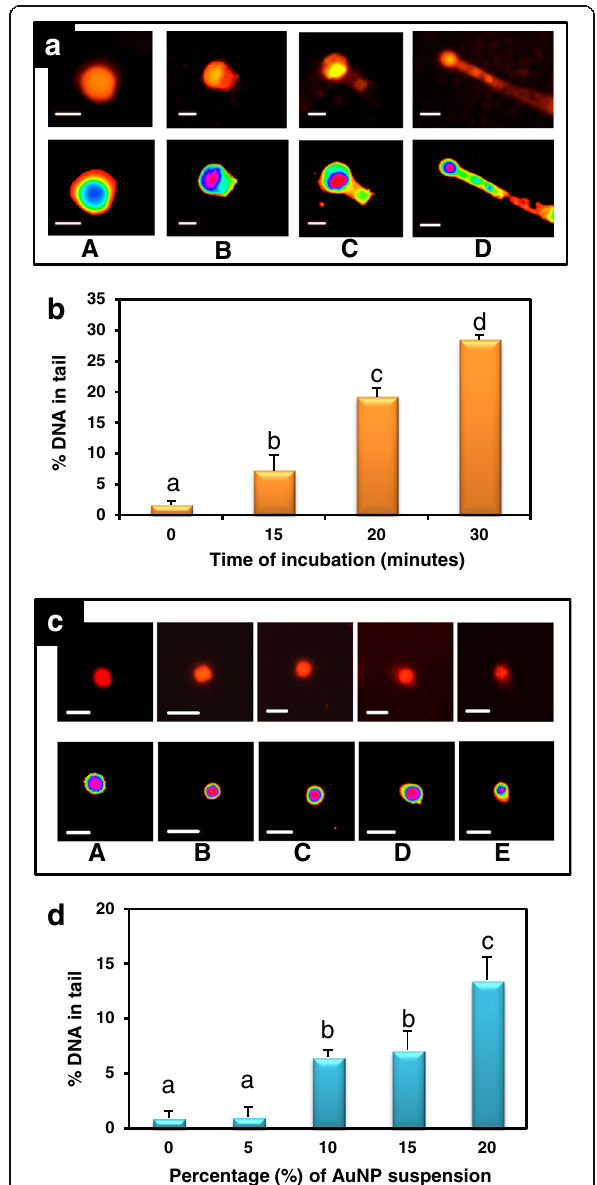
Fig. 8 Assay of apoptotic properties of the AuNPs. a Comet assay and fluorescent microscopic images of nuclei of tobacco leaves treated with AuNPs for A 0 min. B 15 min, C 20 min, and D 30 min (bar=5 μ m). In the control sets (0 min incubation), most of the DNA is located in the head of the comet while cells subjected to longer treatment show increasing DNA damage and longer comet tails. b Mean of % tail DNA ±SE after different periods of incubation. Data represents means±SE of three replicates. Different letters indicate statistically significant differences among the samples ( P <0.05, Tukey ’ s HSD test). c Assay of threshold dosage of AuNPs for apoptosis showing images of nuclei of tomato leaf cells treated with A 0% (control), B 5%, C 10%, D 15%, E 20% of AuNP suspension for 24 h (bar=10 μ m). d Mean % tail DNA±SE after 24 h treatment with different concentration of AuNPs. Data represents means ±SE of three replicates. Different letters indicate statistically significant differences among the samples ( P <0.05, Tukey ’ s HSD test). Dosage below 10% show negligible DNA damage while higher than 20% show start of DNA resulted in gradual increase in apoptosis indicated by in- crease in percentage of DNA in tail (Fig. 8a, ‘ A ’ , ‘ B ’ , ‘ C ’ , ‘ D ’ ). The maximum migration of DNA occurred after 30 min of treatment showing a tail DNA value 28.44 ± 0.74% which was significantly higher than that of untreated con- trol cells (1.7 ± 0.59%). The incubation periods of 15 and 20 min caused less DNA migration with tail DNA values of 7.25 ± 2.56 and 19.19 ± 1.54%, respectively (Fig. 8b). Therefore, these AuNPs have the capacity to induce apop- tosis in eukaryotic cells in higher doses. Recently, nano- particles are being used in novel strategies to target and kill cancer cells. As illustrated by dynamic and quantitative imaging, successful application of nanoparticles as an al- ternative therapy for cancer depends on the apoptotic properties of the particles [36]. Hence, the present finding shows potent apoptogenic properties of these AuNPs which holds promise in future cancer therapy. These AuNPs are non-apoptogenic at lower doses Safe application of metal nanoparticles as therapeutic agent needs a pre-determination of biological effect of the particles at the borderline toxicity [37]. A threshold level of nanoparticles required for apoptosis was ob- tained through treatment of tomato leaf cells with differ- ent concentration of AuNP for 24 h (Fig. 8c). Low concentration, e.g., 5% v / v of AuNP stock suspension (15.56 mg/L) did not show significant apoptogenic effect on tomato cells even after 24 h of exposure. The nuclei after 10% AuNP treatment showed 6.52 ± 0.63 percent- age of DNA in tail which was higher than untreated con- trol nuclei (0.95 ± 0.66 percentage of DNA in tail) and those treated with 5% AuNP suspension (1.04 ± 0.89 per- centage of DNA in tail). Treatment of tomato leaf cells with 15 and 20% AuNP resulted in a slight rise in DNA damage showing 7.15 ± 1.70 and 13.47 ± 2.16 percentage of DNA in tail, showing significant apoptogenic effect (Fig. 8d). Thus, in lower doses apoptogenic effect is neg- ligible holding the possibility for these nanoparticles to